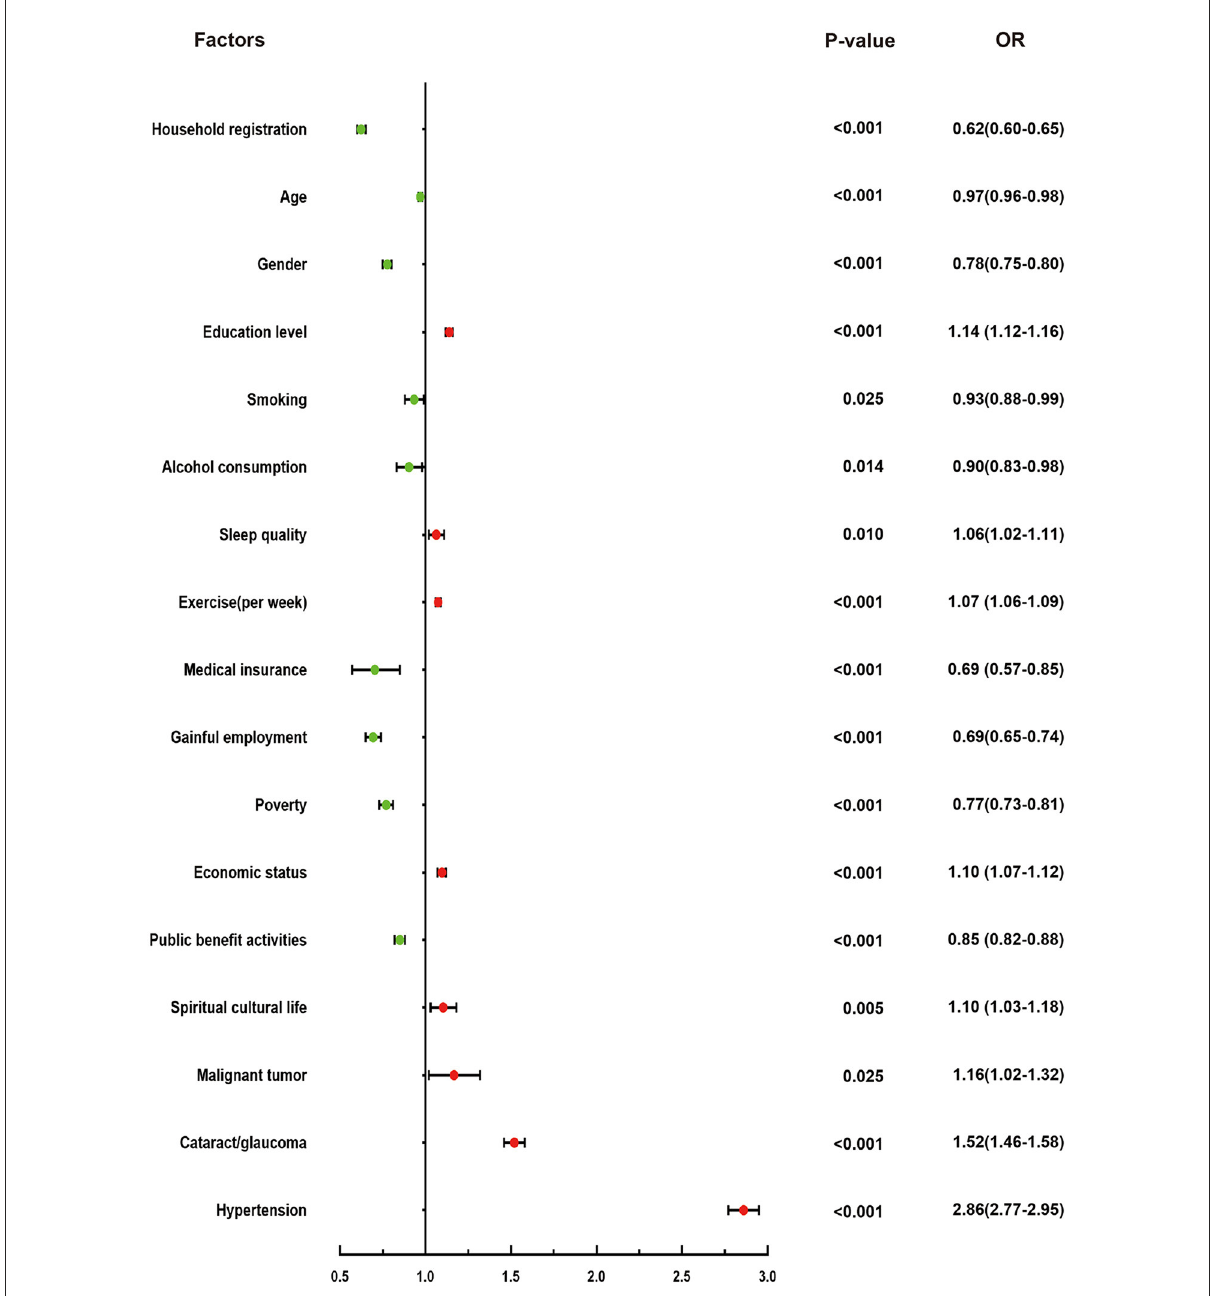
FIGURE4 Association between related factors and diabetes by multivariate logistic regression